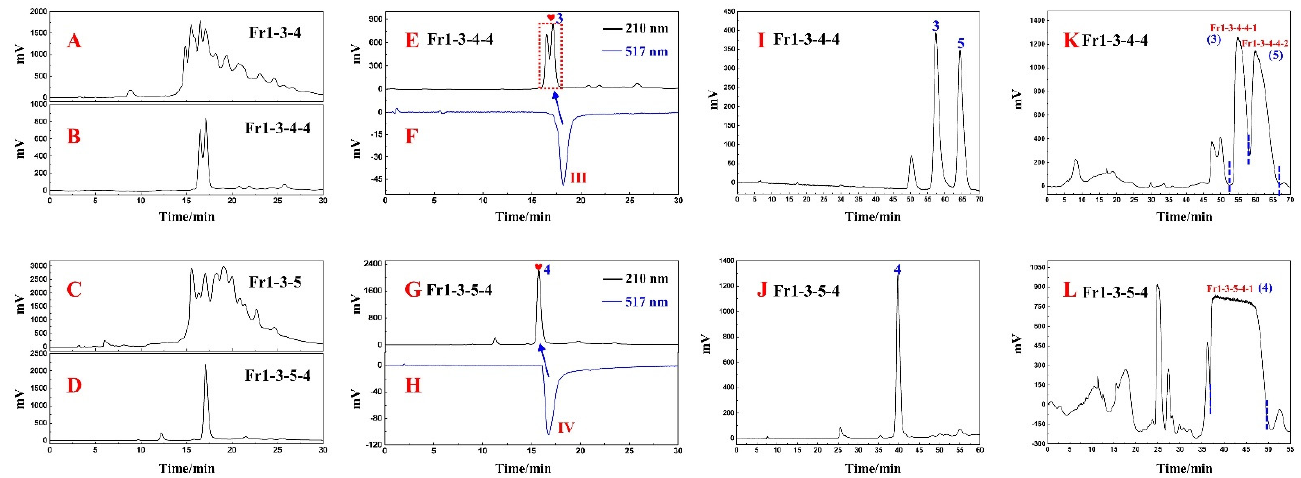
Figure 5. Analytical comparison chromatograms of Fr1-3-4 and Fr1-3-4-4 ( A , B ). Analytical comparison chromatograms of Fr1-3-5 and Fr1-3-5-4 ( C , D ). DPPH inhibitory activity verification chromatogram of the Fr1-3-4-4 ( E , F ), Fr1-3-5-4 ( G , H ) on the ReproSil-Pur C18 AQ analytical column. Fr1-3-4-4 and Fr1-3-5-4 in the analytical chromatograms ( I , J ) and preparative chromatograms ( K , L ) of the ReproSil-Pur C18 AQ column, respectively.